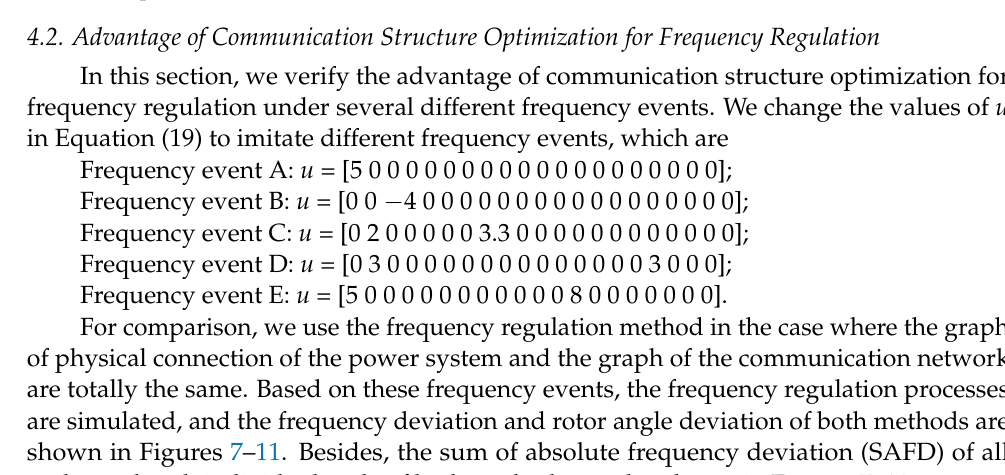
Figure 6. Optimization results of L c for the communication structure.